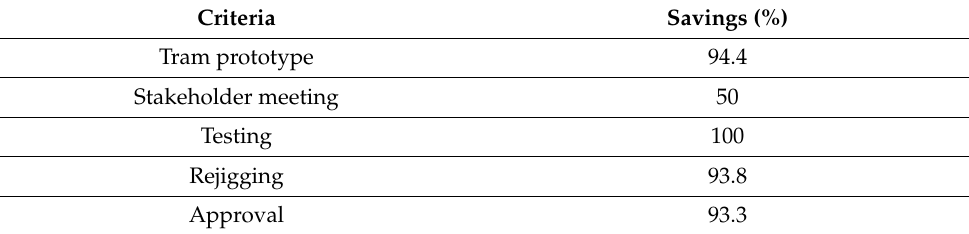
Table 1. Percentage of savings using Metaverse-based